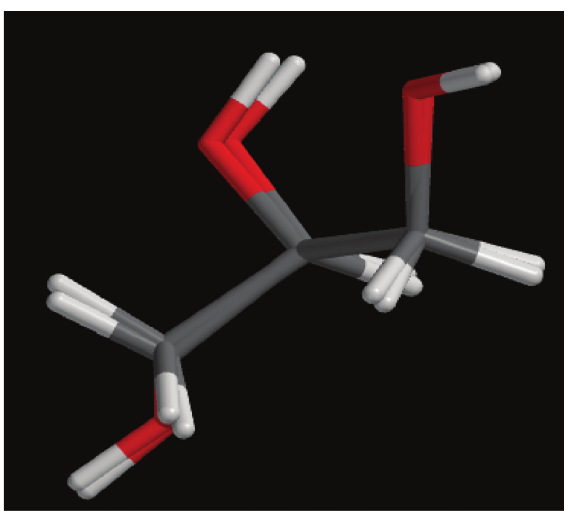
Figure 3: Overlay of native drug-like compounds over redocked drug compound. Table 3: Scoring of selected compounds in Annona muricata seed with 3 α -HSD.